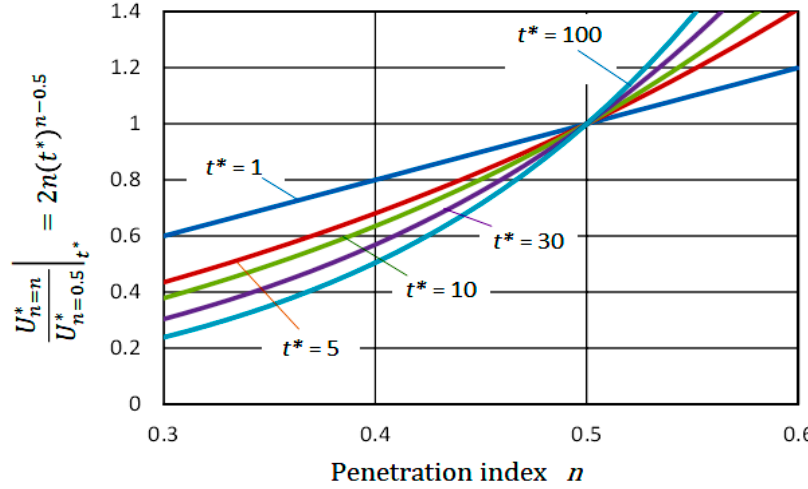
Figure 11. Longitudinal velocity change as a function of index n and timing t * .